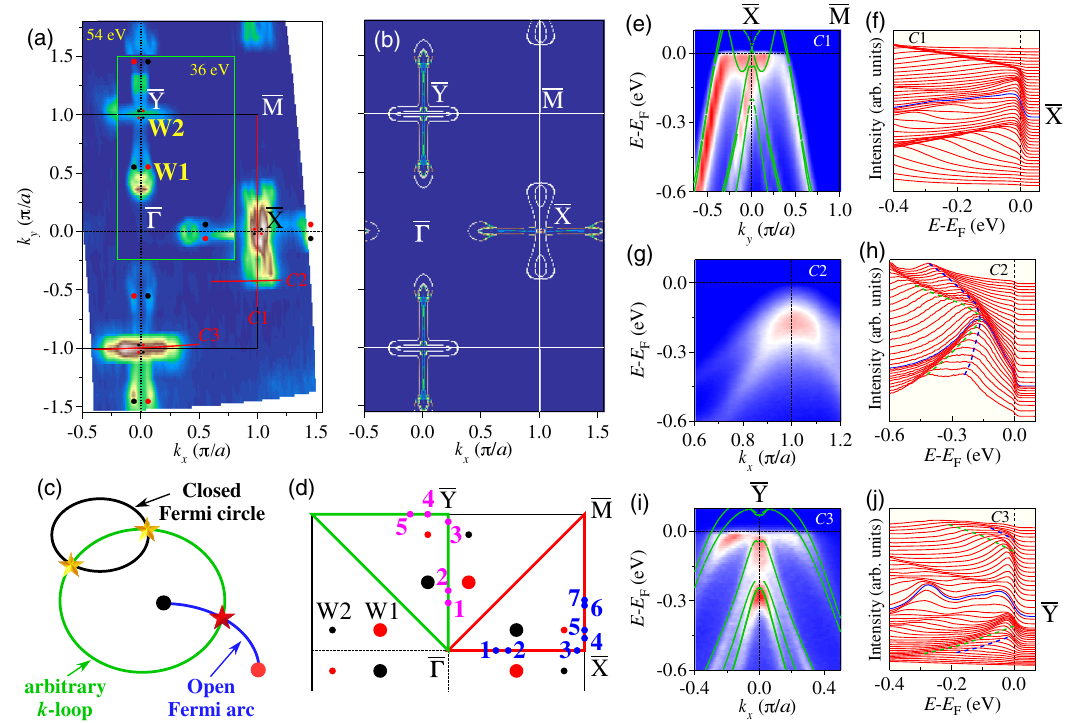
FIG. 3. Fermi surface on the TaAs (001) surface. (a) Photoemission intensity plot at E F in the (001) surface recorded at h ν ¼ 54 (outside the green box) and 36 eV (inside the green box). Larger and smaller circles indicate the locations of W1 and W2 projected onto the (001) surface BZ, respectively. Black and red colors represent opposite chirality. (b) Theoretical Fermi surface in the (001) surface BZ. (c) Schematic of a closed Fermi surface pocket and an open Fermi arc crossing an arbitrary k loop in the two-dimensional case. (d) Blue and magenta circles indicate the locations where the surface bands cross the enclosed k loop respectively. (e,f) Photoemission intensity map and energy distribution curves along as (e,f), respectively, but recorded along C 2 . (i,j) Same as (e,f), respectively, but recorded along calculated-surface-state bands along lines in (h) and (j) track the band